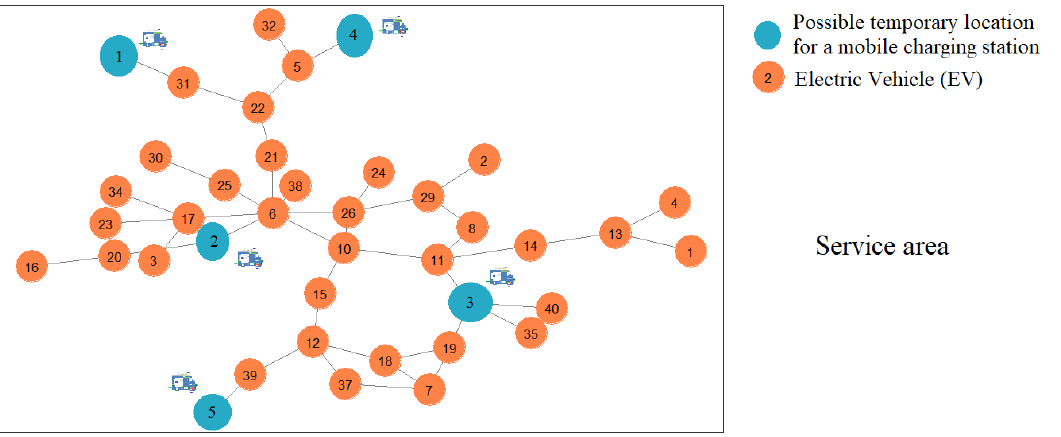
Figure 1. Operational mode of a mobile charging